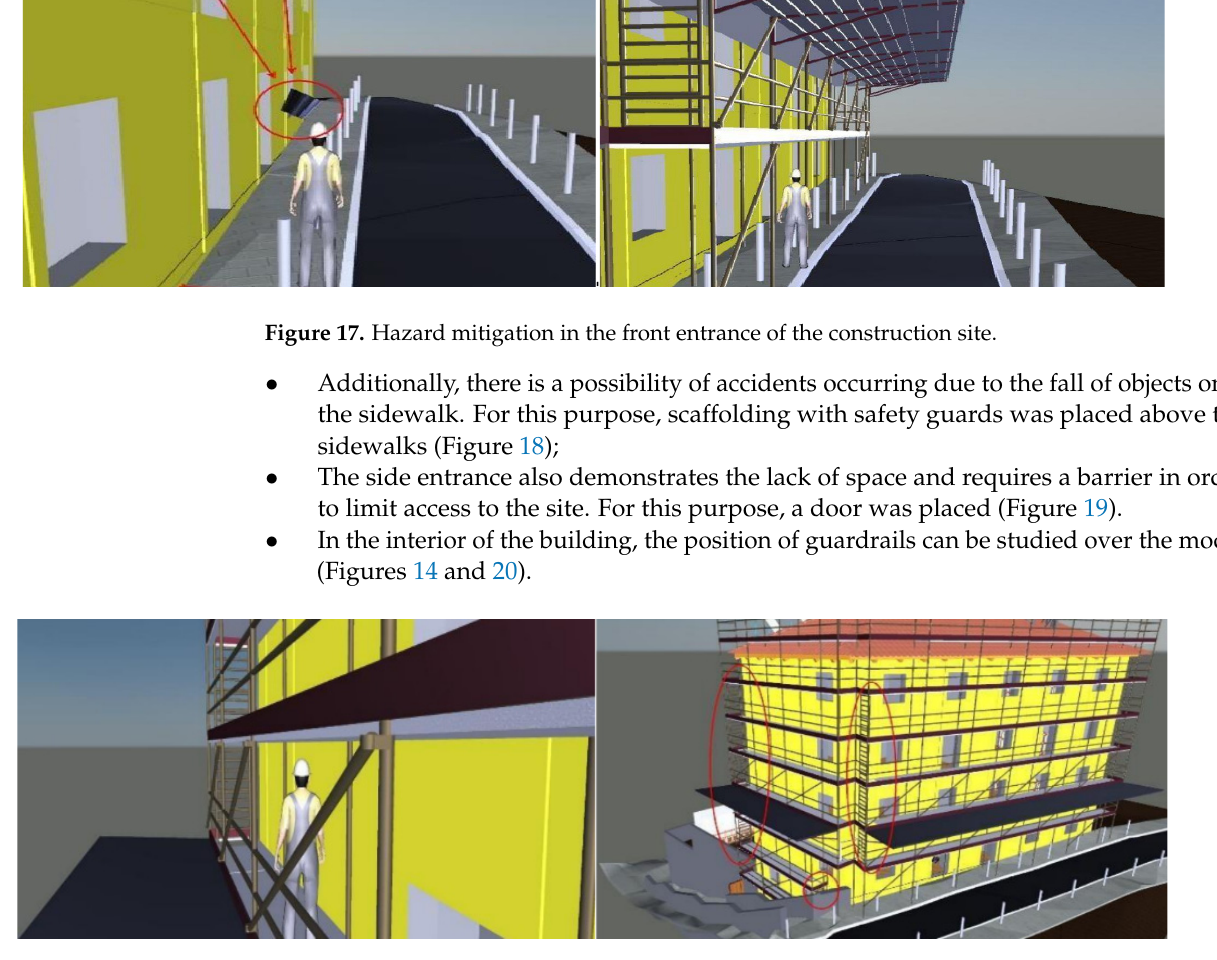
Figure 18. Circulation path over a scaffolding.